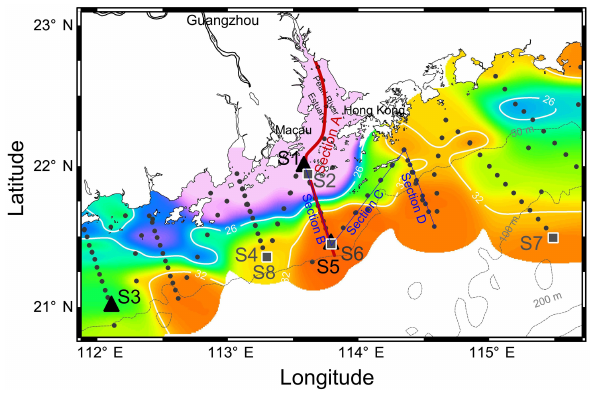
Figure 1. Sampling map in the NSCS shelf during May–June 2016. Color is the surface salinity of three cruises with the frontal zone by white lines of 26 and 32 (nearshore and offshore boundaries of the plume). Section A is across the front from the PRE to the shelf; section B is across the front with sections C and D on the sea side. Triangles are incubation sites S1, S3 and S5 during May 2016 and squares are incubation sites S2, S4, S6, S7 and S8 during June 2016. Locations of S6 and S8 are overlaid with S5 and S4, respectively. Dots are the stations and dashed lines are the